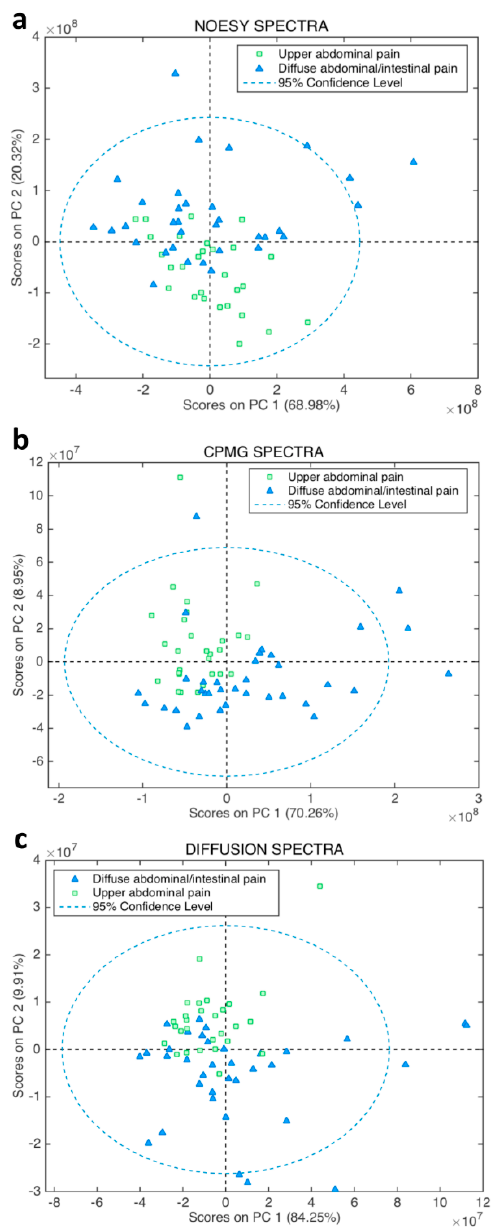
Figure 1. 2D Score plot of the Principal Component Analysis (PCA) analysis for the NMR serum spectra of the patients participated in this study. The data are colored according to two groups: diseases with sever upper abdominal pain ( n = 29, green squares) and diffuse abdominal/intestinal pain ( n = 35, light blue triangles). PCA analyses were performed for the serum ( a ) Nuclear Overhauser Effect Spectroscopy (NOESY), ( b ) Carr-Purcell-Meiboom-Gill (CPMG), ( c ) diffusion NMR spectra.